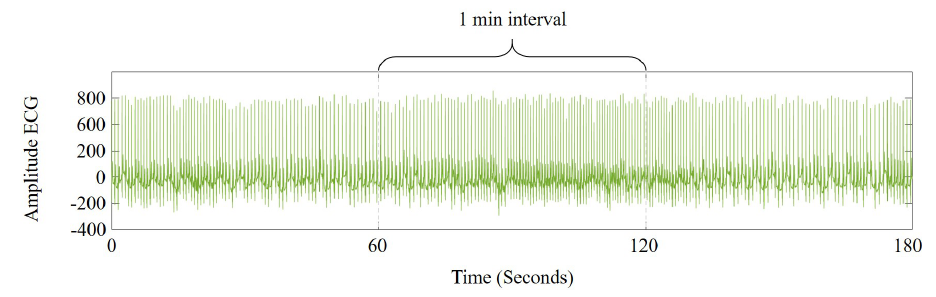
Figure 3. Example of an ECG signal from a healthy subject.